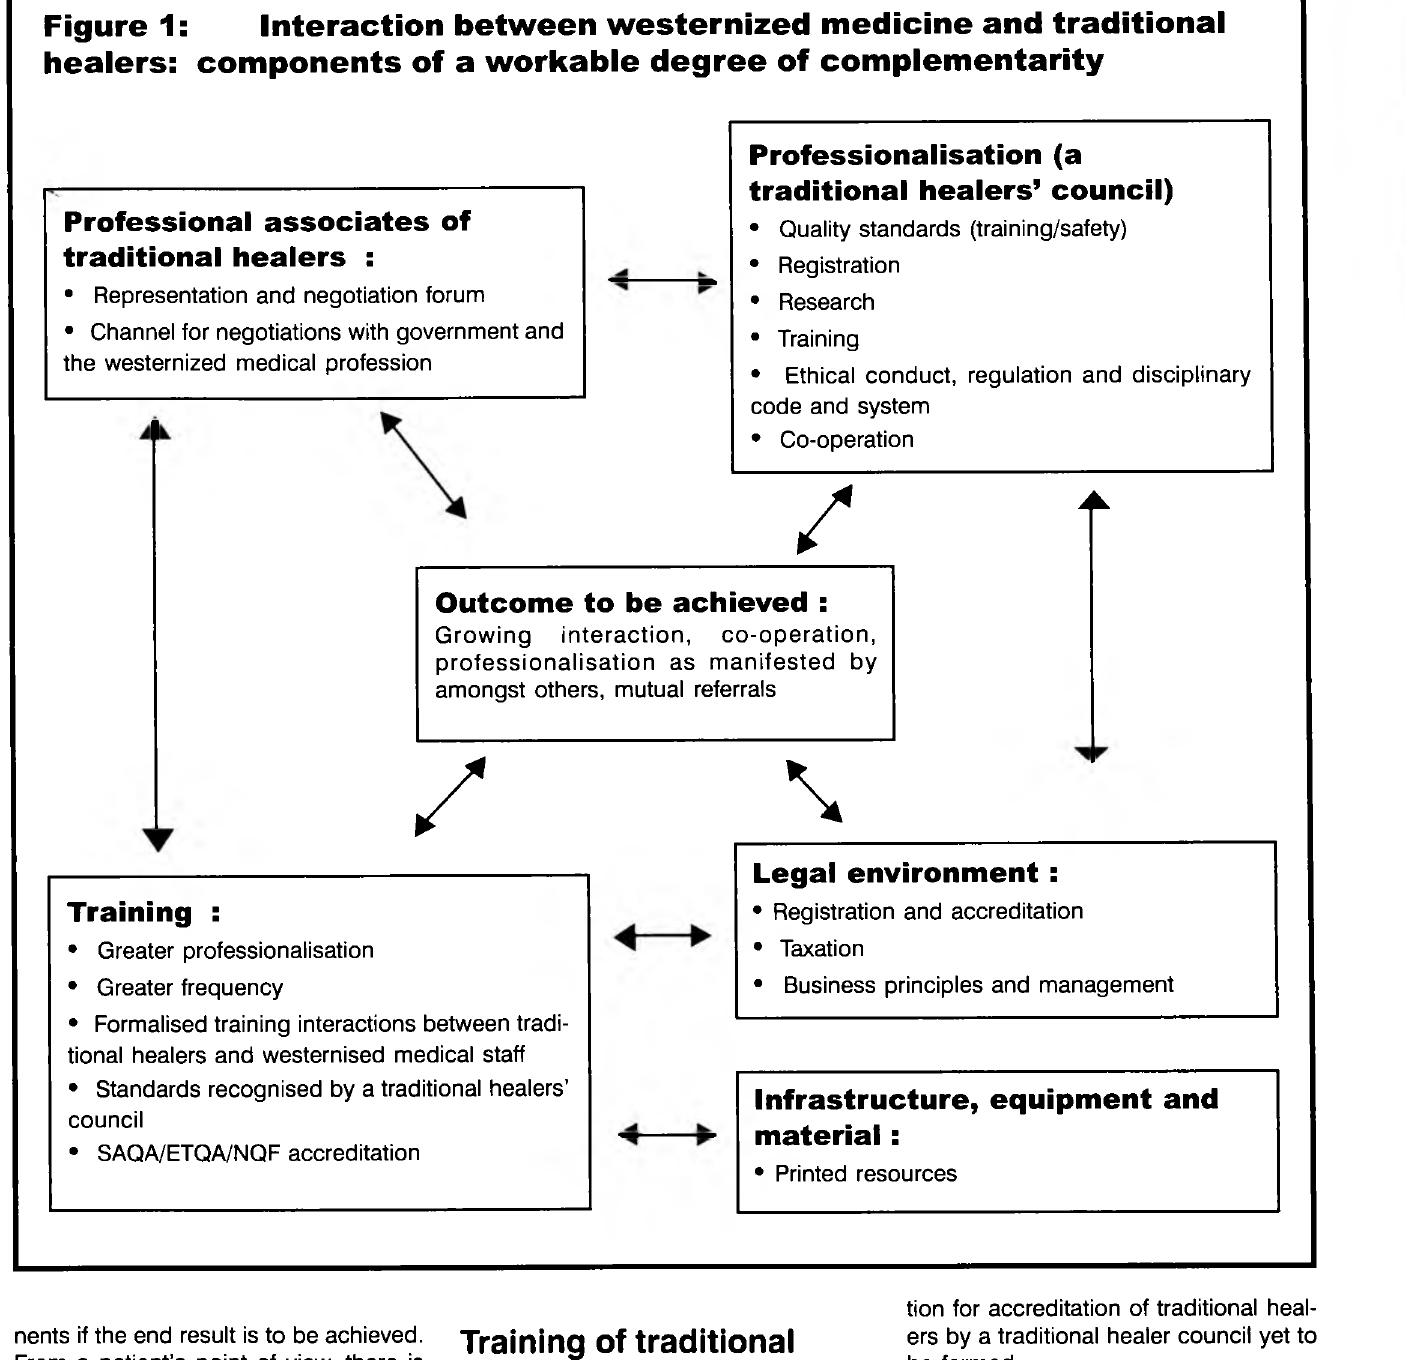
Figure 1: Interaction between westernized medicine and traditional healers: components of a workable degree of complementarity